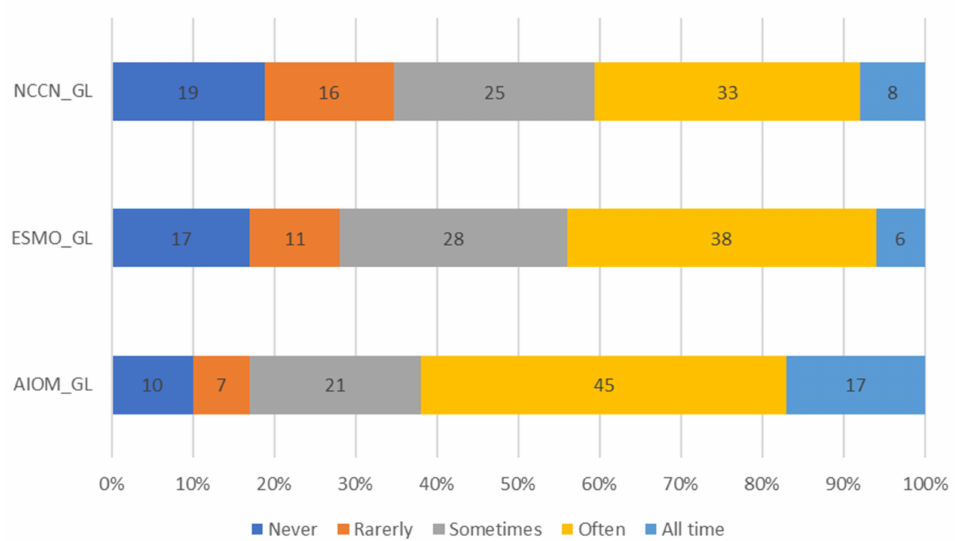
Figure 4. Adherence to guidelines. Legend: NCCN, National Comprehensive Cancer Network; ESMO, European Society for Medical Oncology; AIOM, Italian Association of Oncologists; GL, guidelines.